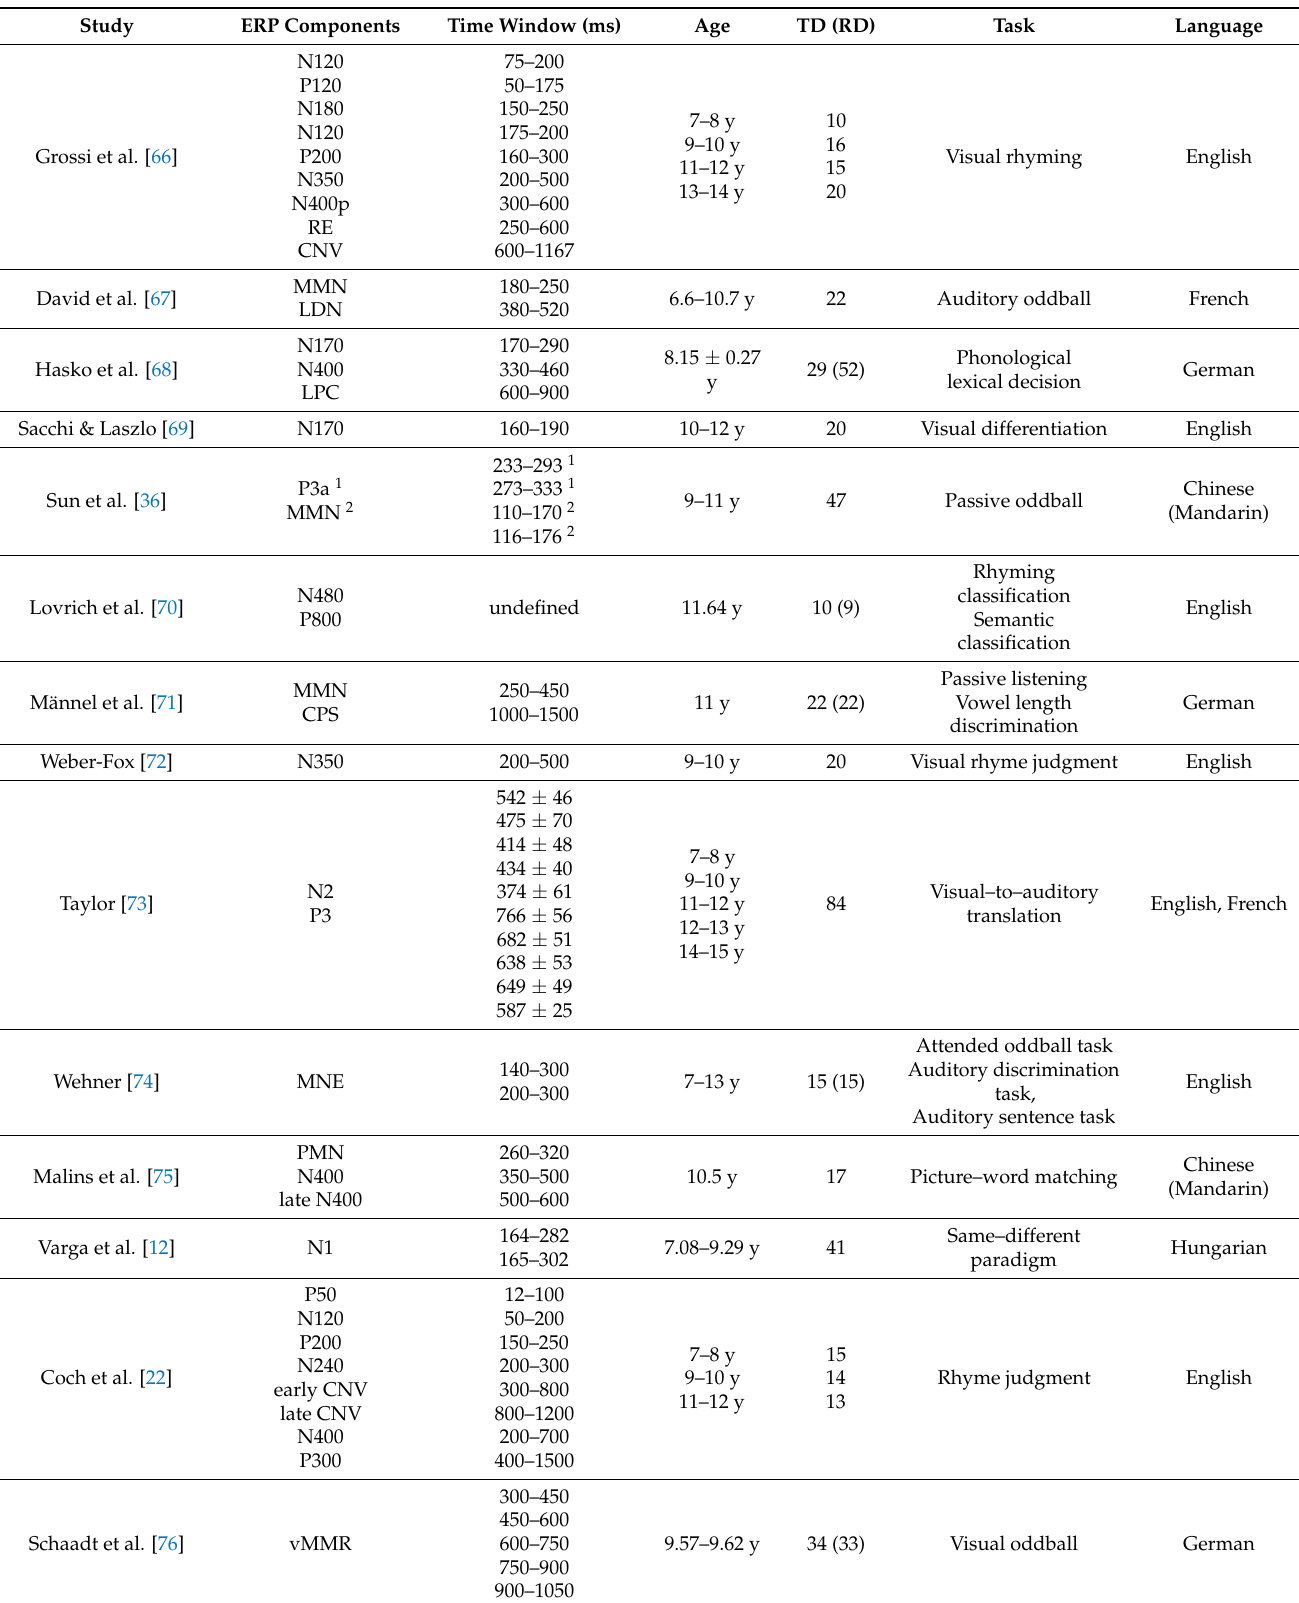
Table 3. Overview of the publications selected for review; studies with school aged children and beginner